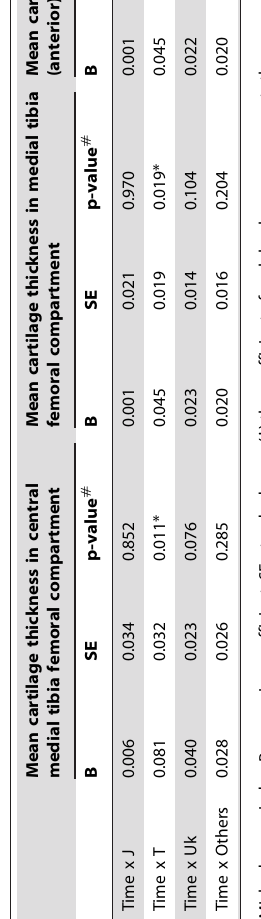
Figure S1 Sagittal RM images (DESSwe sequence) with the cartilage of MF being divided into cMF and pMF at 60% (left) and 75% (right) of the distance between the trochlear notch and the posterior end of the femoral condyle; MT: medial tibia; MF: medial femoral condyle; cMF: central (weight bearing) medial femoral condyle; pMF: posterior medial femoral condyle. (TIF) Figure S2 Representative subregions of the knee used to track changes in cartilage thickness and volume. cMF: central (weight-bearing) medial femoral condyle; MT: medial tibia; cLF: central (weight-bearing) lateral femoral condyle; LT: lateral tibia; ccMF: central subregion of central (weight-bearing) medial femur; cMFTC: central medial femoro-tibial compart- ment; cMT: central subregion of medial tibia; aMT: anterior subregion of medial tibia. (TIF) Table S1 Longitudinal change between baseline (T0) and 24 months (T2) in quantitative parameters of cartilage integrity (volume and thickness) grouped by mitochondrial DNA (mtDNA) haplogroups. (DOCX) Table S2 Cross-sectional differences among the mitochondrial DNA (mtDNA) haplogroups in quantitative parameters